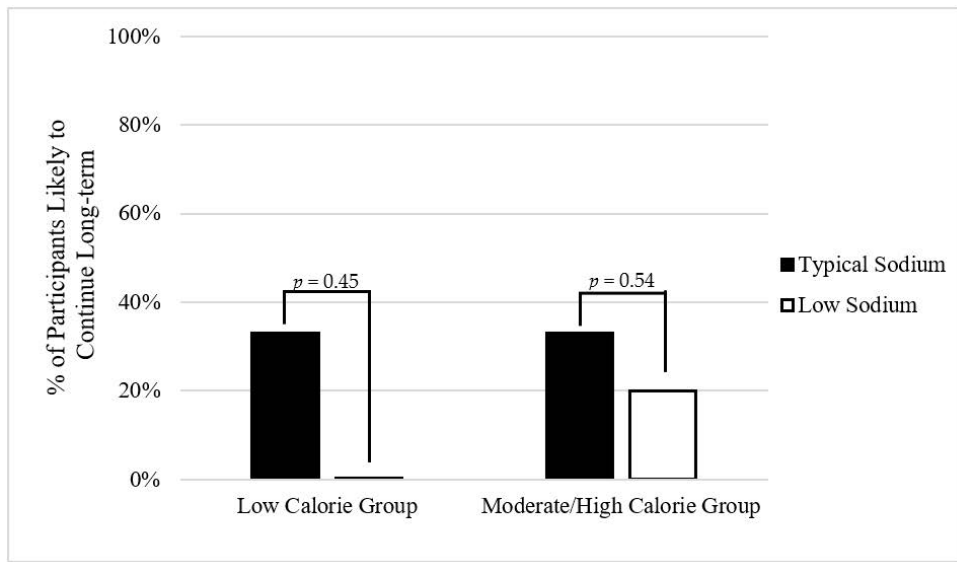
Figure 1. Self-reported willingness to continue meal plans long-term by diet and calorie group. Twelve participants were in the low calorie group (typical sodium, n = 6; low sodium, n = 6), and eight participants were in the moderate/high calorie group (typical sodium, n = 3; low sodium, n = 5).